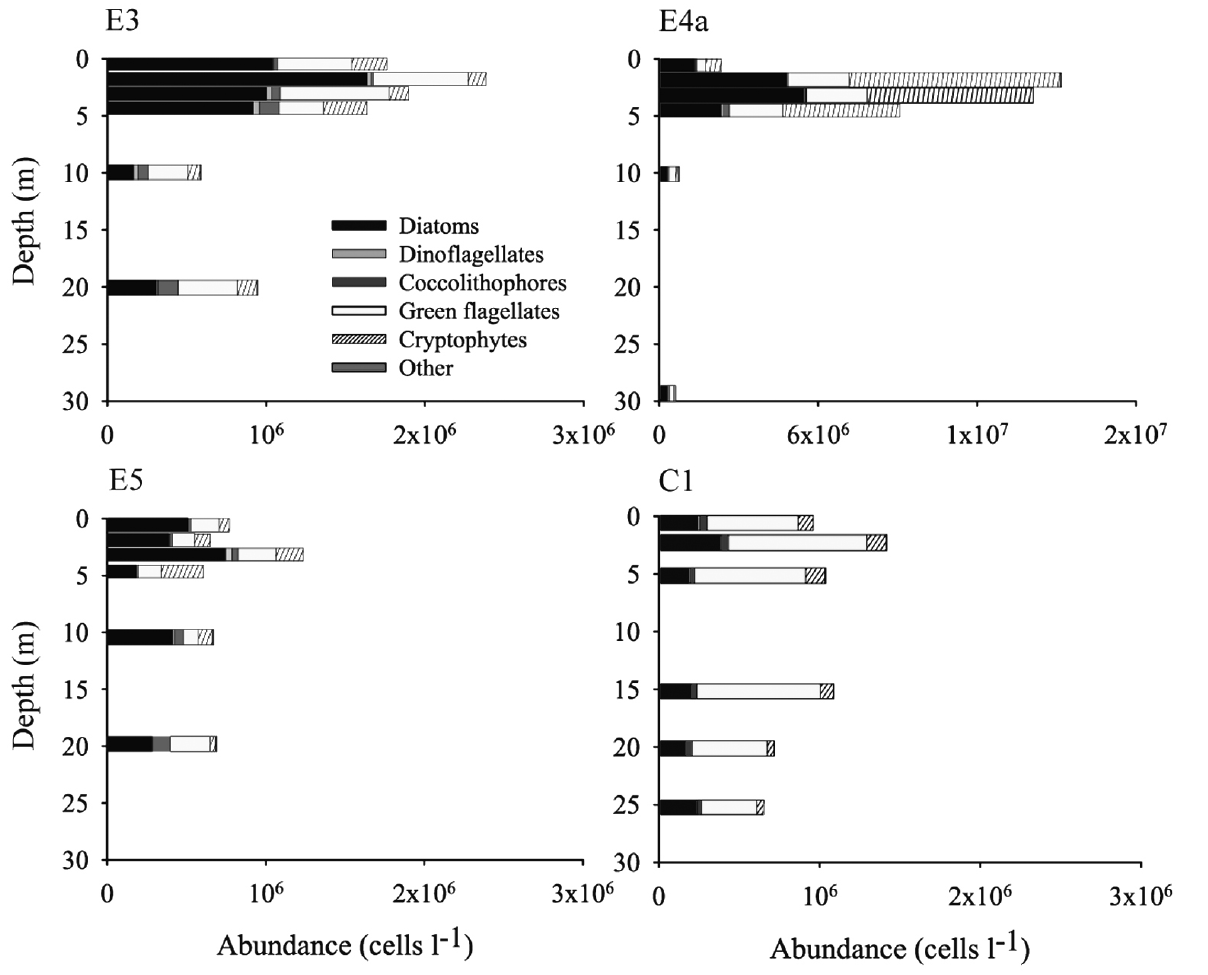
Fig. 6. – Bar chart presentation of the abundance of main phytoplankton groups at the sampled depths. Note the larger scale on the graph presenting station